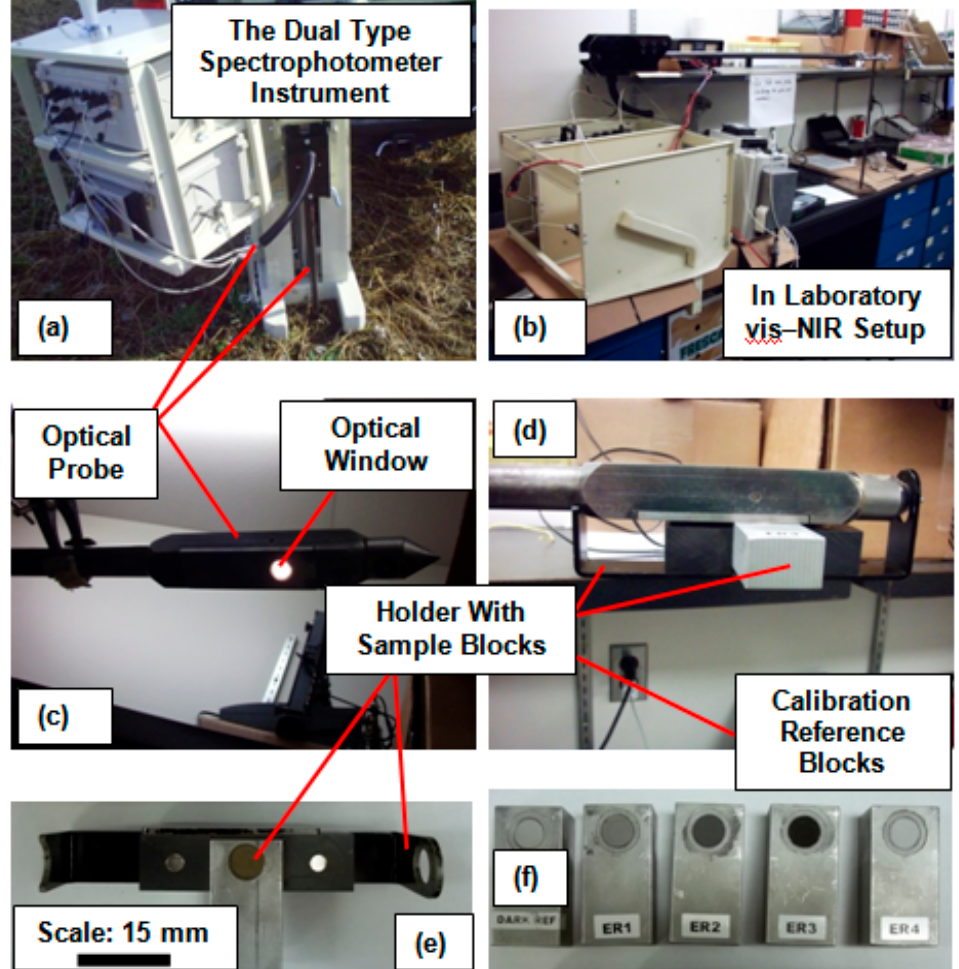
Figure 2. Illustration of the field and laboratory configurable portable vis-NIR spectrophotometer (transportable field setup ( a ), laboratory setup with vis-NIR probe ( b ), the optical window made out of sapphire ( c ), vis-NIR probe with sample and its holder for collection of vis-NIR spectra ( d ), sample holder attachment with sample holder filled with soil sample ( e ), and reference blocks for spectral calibrations ( f )).